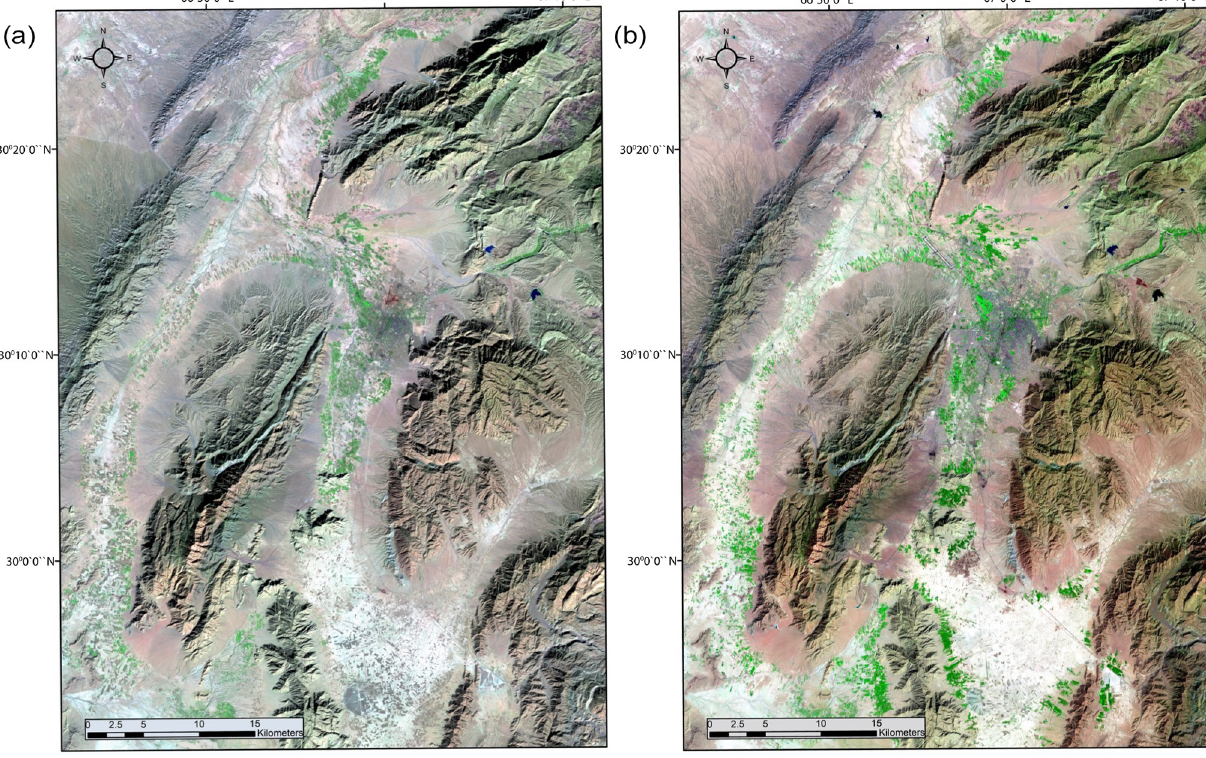
Figure 9. ©Landsat Thematic Mapper bands 7, 4 and 2 displayed as red, green and blue showing the vegetation increase overtime in Quetta valley. (a) is from 21 June 1987 whereas (b) is from 16 August 2011. Increase in vegetation can be seen in bright green colors in the northern and southern end of Quetta